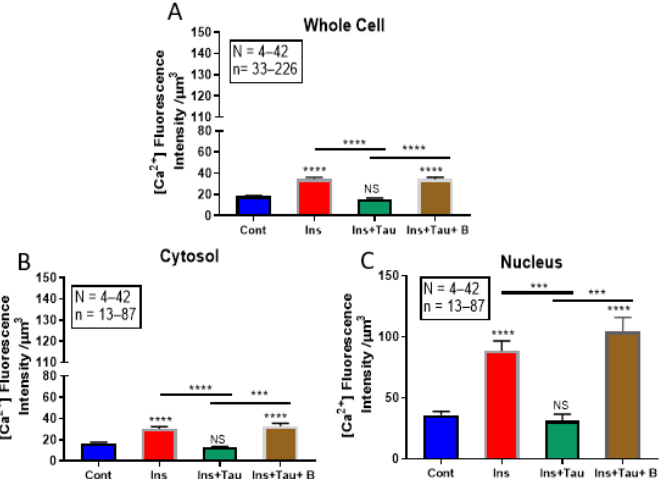
Figure 7. Histograms showing the effect of a 48-h treatment with insulin (80 µ U/mL), insulin (80 µ U/mL) with taurine (20 mM), and insulin (80 µ U/mL) with taurine (20 mM) and β -alanine (500 µ M) on the whole-cell ( A ), cytosolic ( B ), and nuclear ( C ) calcium levels of adult rat ventricular cardiomyocytes. The values are represented as mean ± standard error of the mean. N represents the number of animals, and n represents the number of cells., *** p < 0.001, and **** p < 0.0001. Cont = control; ins = insulin; tau = taurine’ and B = β -alanine. Calcium’s relative concentration is expressed in µ m 3 .